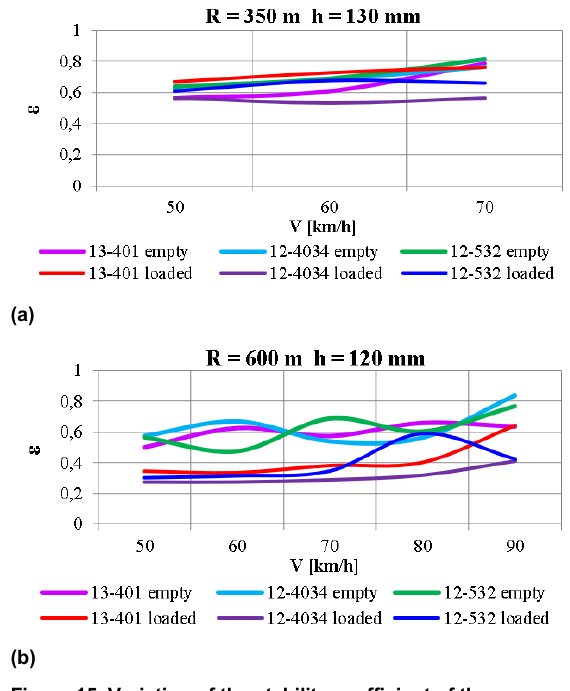
Figure 15. Variation of the stability coefficient of the assem– bled rails and sleepers from the transverse forces action with the motion speed: (a) R=350 m curve; (b) R=600 m